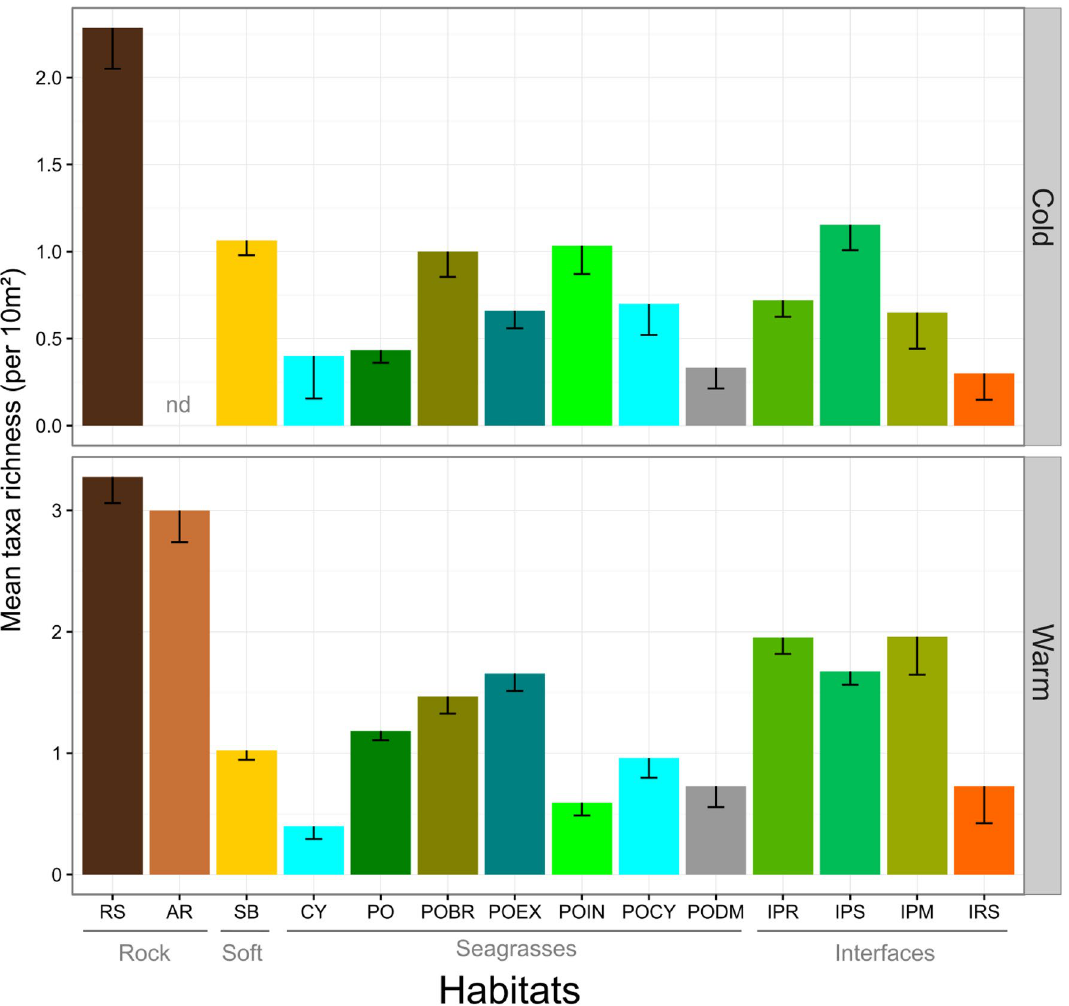
Figure 4. Mean taxa richness (± SE) of juvenile fishes per 10 m 2 in shallow coastal juvenile habitats for both periods (Cold and Warm). RS: Rocky substrates; AR: Artificial rocky reefs; SB: soft bottoms; CY: Cymodocea beds; PO: Posidonia oceanica beds; POBR: Posidonia barrier reef flat; POEX: Posidonia barrier reef outer slope; POIN: Posidonia barrier reef inner slope; POCY: Barrier reef lagoon with Cymodocea ; PODM: Posidonia dead matte; IPR: Interface Posidonia /Rocky substrates; IPS: Interface Posidonia /Soft bottoms; IPM: Interface Posidonia /Dead matte; IRS: Interface Rocky substrates/Soft bottoms. Main habitat categories are indicated in (6.2%). On rocky substrates (RS), no difference in juvenile fish assemblage according to the relative impor- tance of macroalgal cover types ( Cystoseira forest, bushland or turf/encrusting) was observed (PERMANOVA, F = 0.87, P = 0.531). While the assemblage differed with period (pair-wise test, t = 1.594, P = 0.025), Sarpa salpa was the most abundant species on RS in both periods, followed by Diplodus annularis , Boops boops and Sympho- dus spp. in the warm period, and by D. sargus , Mugil spp., and Thalassoma pavo in the cold period (Fig. 6). S. salpa also dominated in abundance on artificial structures (AR) in warm period, with Symphodus spp., Oblada melanura and Coris julis . On soft bottoms (SB), Gobiidae followed by S. salpa dominated in both periods, while the assemblage statistically differed (t = 3.406, P < 0.001). During the warm period, Mugil spp., D. sargus and D. puntazzo were also abundant on SB and particularly associated with high percentages of pebbles and gravel, while Pagellus spp., Lithognathus mormyrus , Mullus spp., Trachinidae, Bothus sp. and Solea sp. were more associ- ated with sand. During the cold period, D. vulgaris was particularly abundant on SB and mainly associated with pebbles and gravel. In Posidonia beds (PO), the juvenile fish assemblage slightly differed according to the type of substrate P. oceanica was growing on. Higher abundances of D. annularis and Symphodus spp. were recorded when the seagrass was growing on sand, and of O. melanura and S. salpa when growing on rocky substrates. A seasonal variation was observed in PO (t = 3.298, P < 0.001) with high abundances of Pagellus spp., S. salpa , Symphodus spp. during the warm period, and the dominance of D. vulgaris in the cold period. Oblada melanura remained abundant all the year in PO. In the different barrier reef habitats, the juvenile assemblage differed with periods, while some species dominated in both periods, such as S. salpa in POBR (t = 2.335, P < 0.001) and PODM (t = 2.048, P = 0.007), Symphodus spp. in POEX (t = 2.651, P < 0.001), and Gobiidae plus Pagellus spp. in